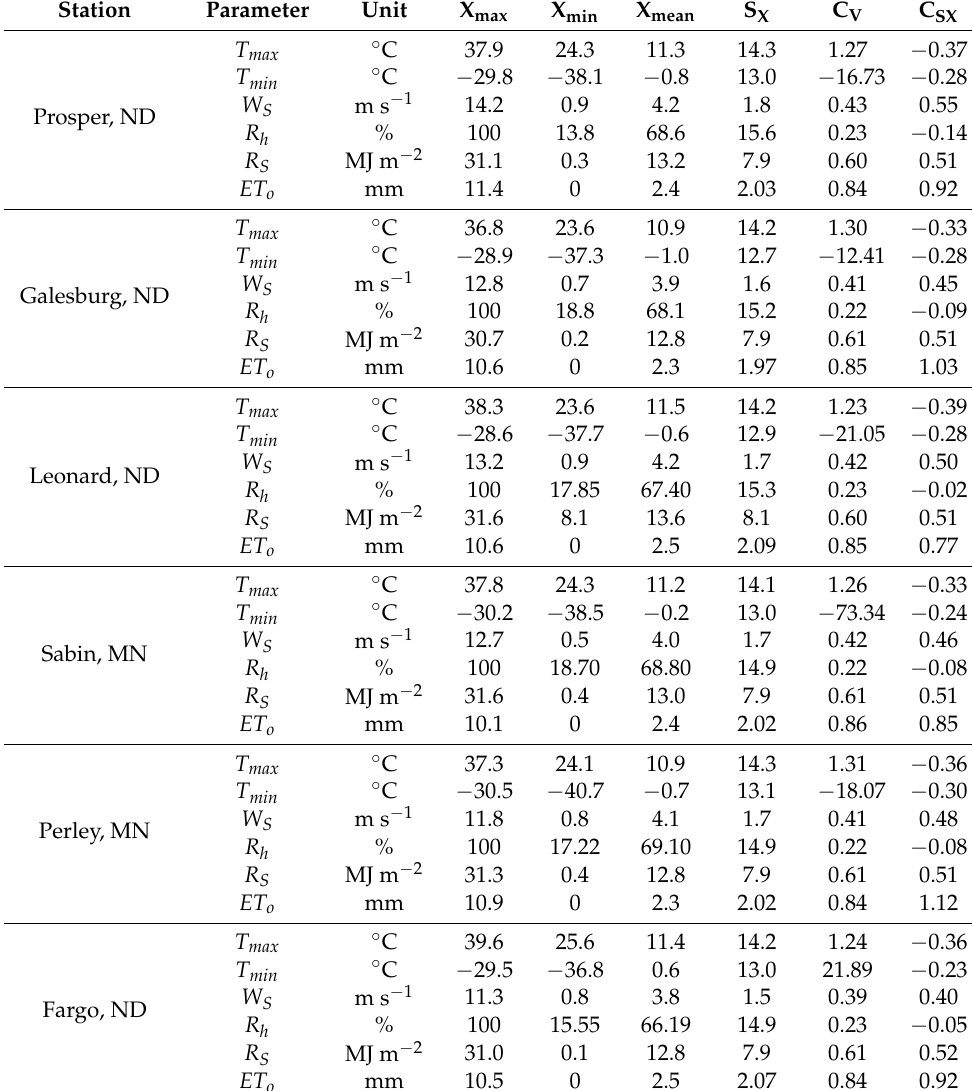
Table 1. Statistical summary of the weather data for the study locations for the study